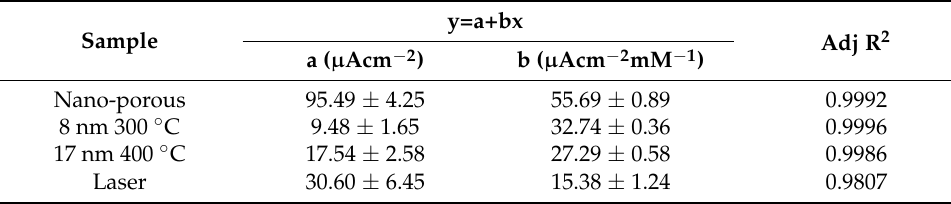
Table 2. parameters used for the linear fit of the calibration curves reported in Figure